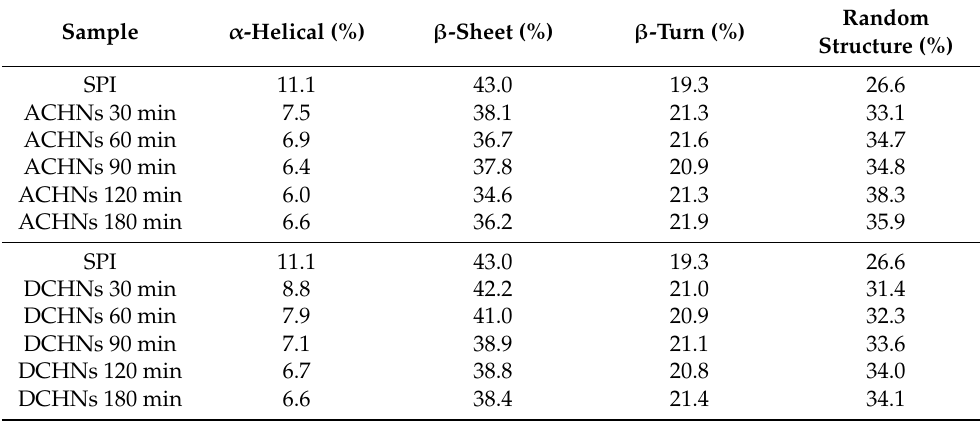
Table 1. Secondary structure content of SPI (soybean protein) and hydrolysates.